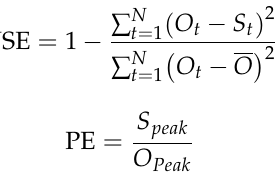
where N represents the number of data, O t represents the observed value at time t , O represents the mean of the observed value, S t represents the simulated value of the model at time t , and O peak and S peak represent the observed and simulated peak values,